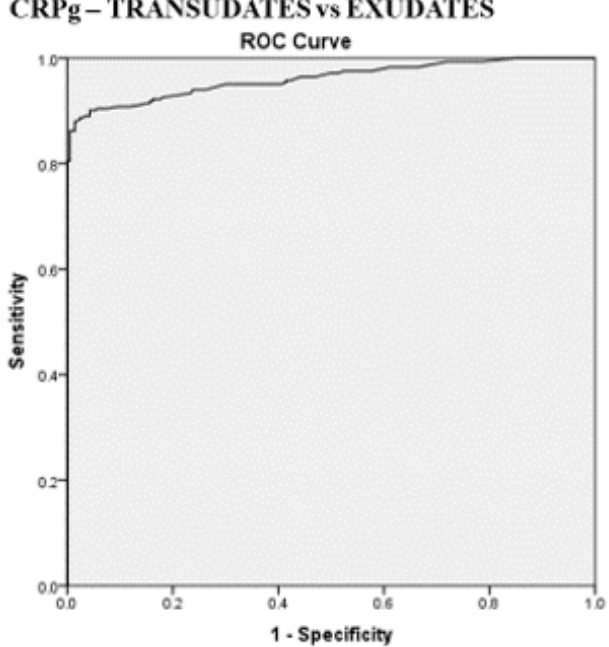
Figure 7. ROC curve of best cut-off value of serum and pleural fluid CRP gradient (CRPg), and its statistical characteristics, for discrimination between transudative pleural effusion and exudative pleural effusion. CRPg best cut-off value = 13.6 mg/L, AUC = 96.1% (95% CI: 94.4–97.7), sensitivity = 90%, specificity = 96%, total accuracy = 92%, PPV = 97%, NPV = 88%, odds ratio = 202.6 (risk for exudate when CRPg value > 13.6 mg/L), p < 0.0001.